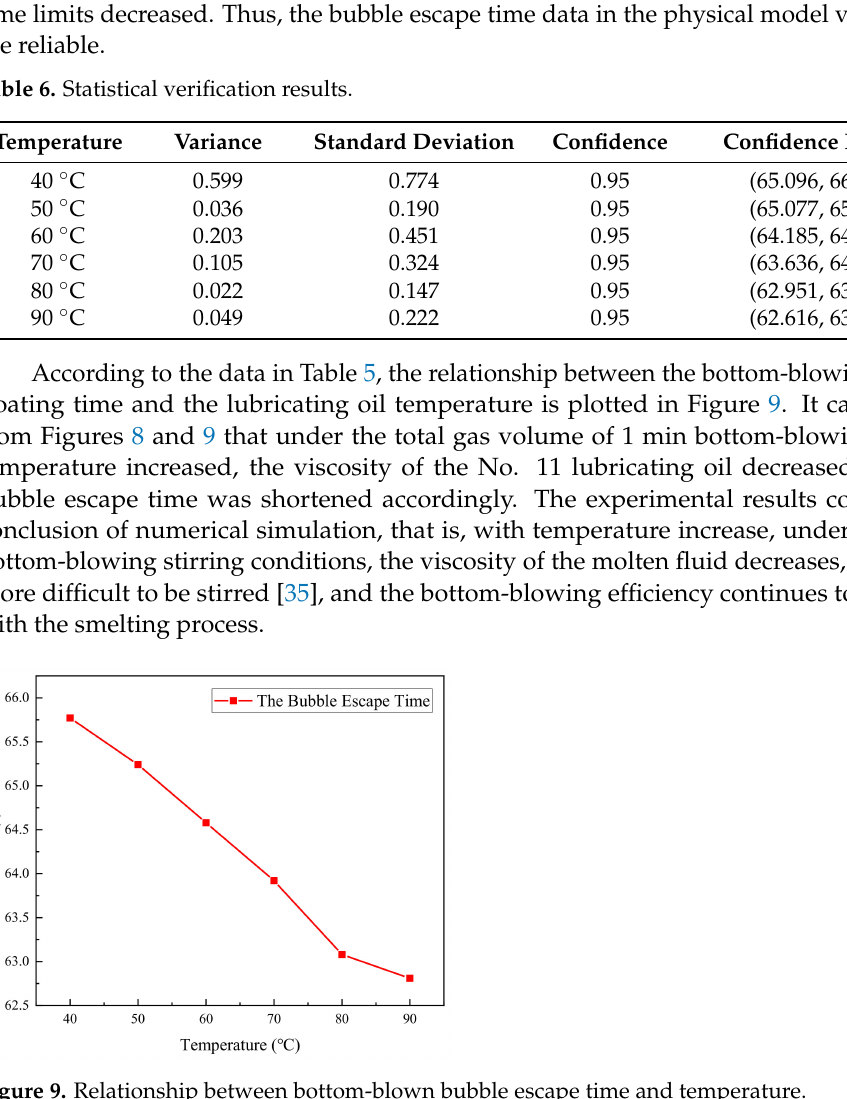
Figure 9. Relationship between bottom-blown bubble escape time and temperature.